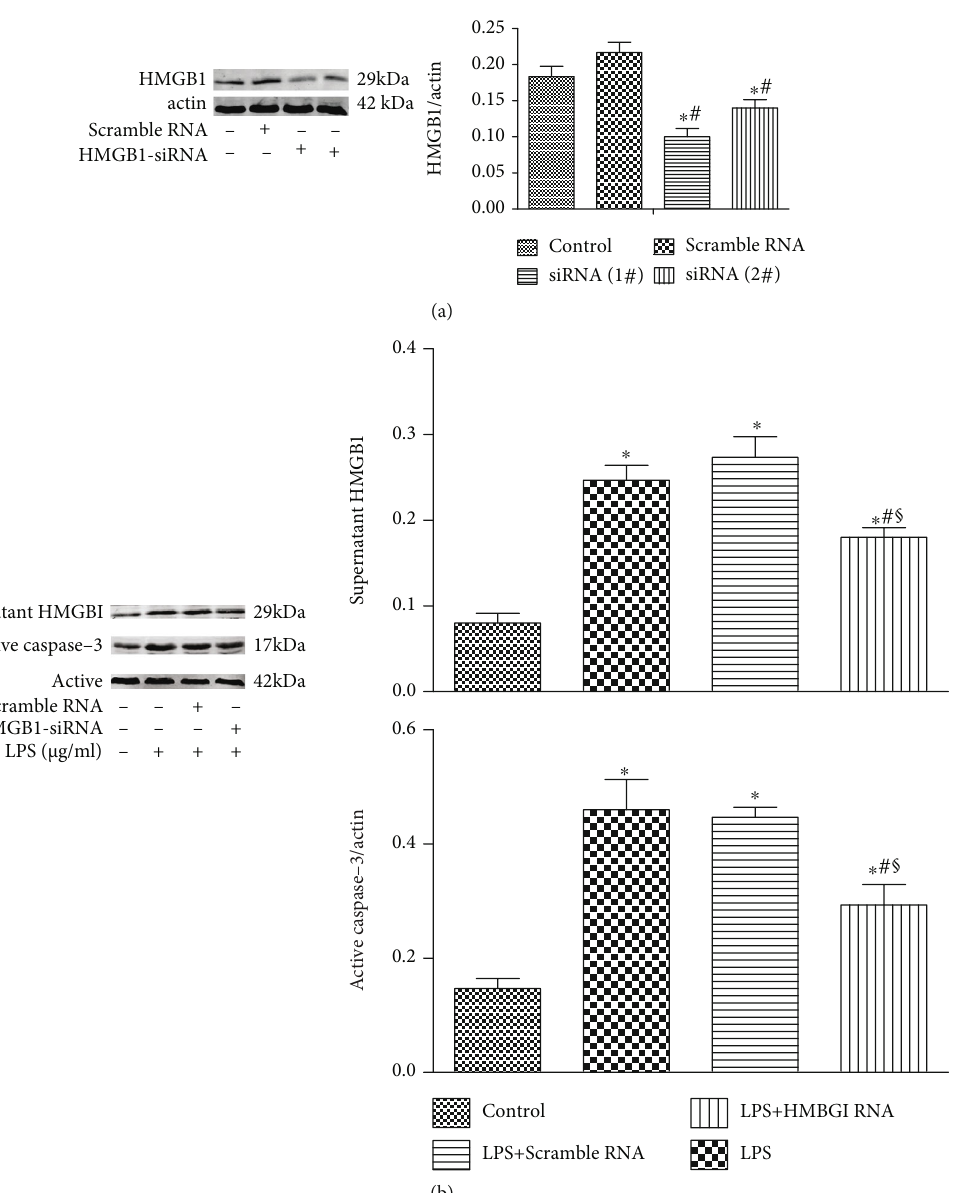
Figure 4: Knockdown of HMGB1 attenuates LPS-induced podocyte injury. (a) Representative Western blotting analysis of HMGB1 expression in podocytes after HMGB1 siRNA transfection. (b) Representative Western blotting analysis image of supernatant HMGB1 and active caspase-3 expression in podocytes transfected by HMGB1 siRNA after exposure to LPS for 24 h. ∗ P < 0 : 05 compared with the control group; # P < 0 : 05 compared with HMGB1 group; § P < 0 : 05 compared with the scramble